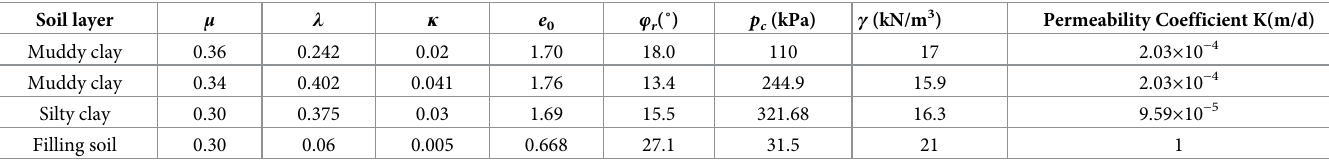
Table 6. Parts of the experimental parameters of the fractional differential constitutive model. Soil layer